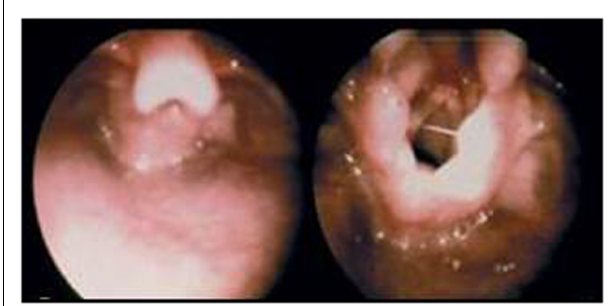
FIGURE 4 | Left, severe laryngomalacia with epiglottic collapse with inspiration; Right, tight aryepiglottic folds and redundant arytenoid mucosa with inspiration